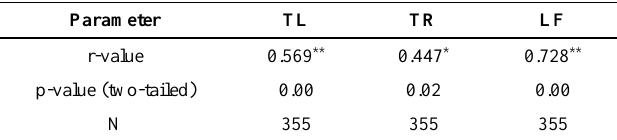
Table 3. Correlation of leadership style with faculty